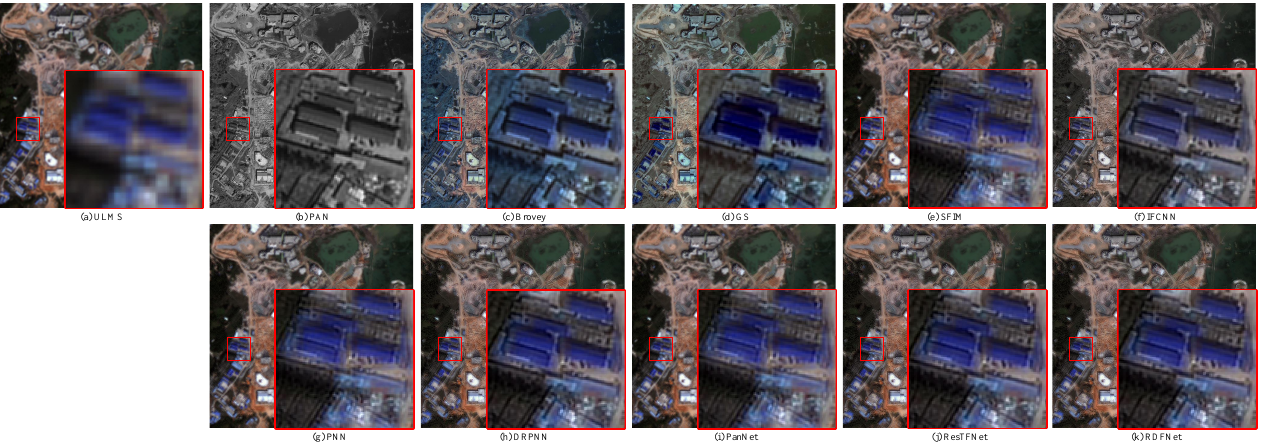
Figure 31. Subjective comparison between RDFNet and the current mainstream fusion methods for fusion results on the GF-2 testing dataset with full resolution. ( a ) ULMS; ( b ) PAN; ( c ) Brovey; ( d ) GS; ( e ) SFIM; ( f ) IFCNN; ( g ) PNN; ( h ) DRPNN; ( i ) PanNet; ( j ) ResTFNet; ( k ) RDFNet